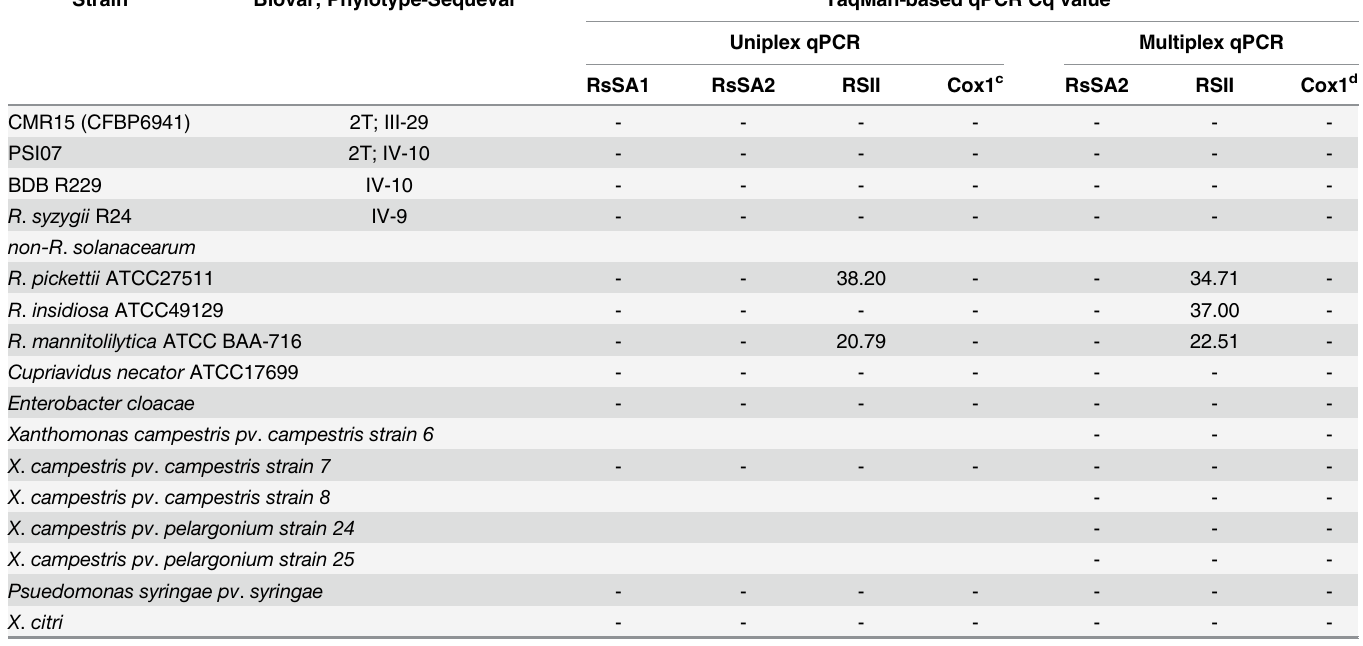
cearum egl sequences representing almost all of the sequevars as previously described [23].